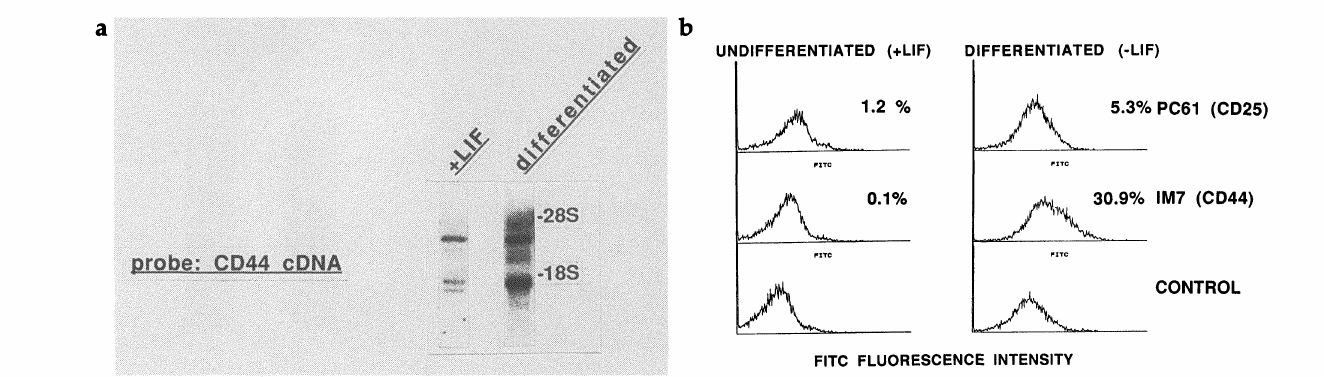
FIGURE 2. In vitro differentiation of ES/D3 cells induces CD44 mRNAs and surface expression. (a) Northern blot on total RNA of undifferentiated ES cells cultured in LIF (left), and ES cells differentiated for week in substrate-attached cultures (right), hybridized to the standard CD44 cDNA probe. (b) FCM analysis of CD44 expression. Shown are fluorescence histograms of undifferentiated (left panels) or differentiated (right panels) ES cells stained with (from bottom to top) the second step reagent alone (Control), anti-CD44 (middle histograms), or anti-CD25 (upper histograms). The figures in each panel show the percentage cells staining above the